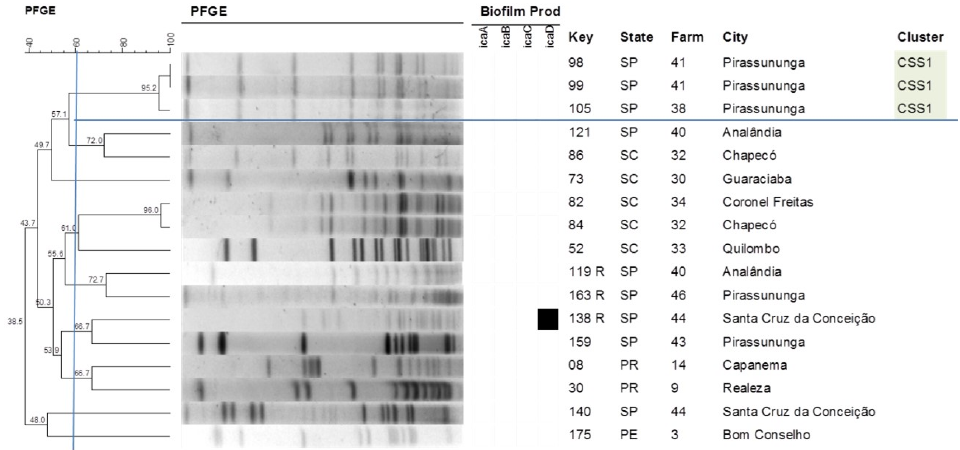
Figure 5. Dendrogram generated from the PFGE pattern of Staphylococcus saprophyticus isolates (Dice similarity coefficient; clustering method: UPGMA). All Staphylococcus saprophyticus isolates were negative for the bhp gene.